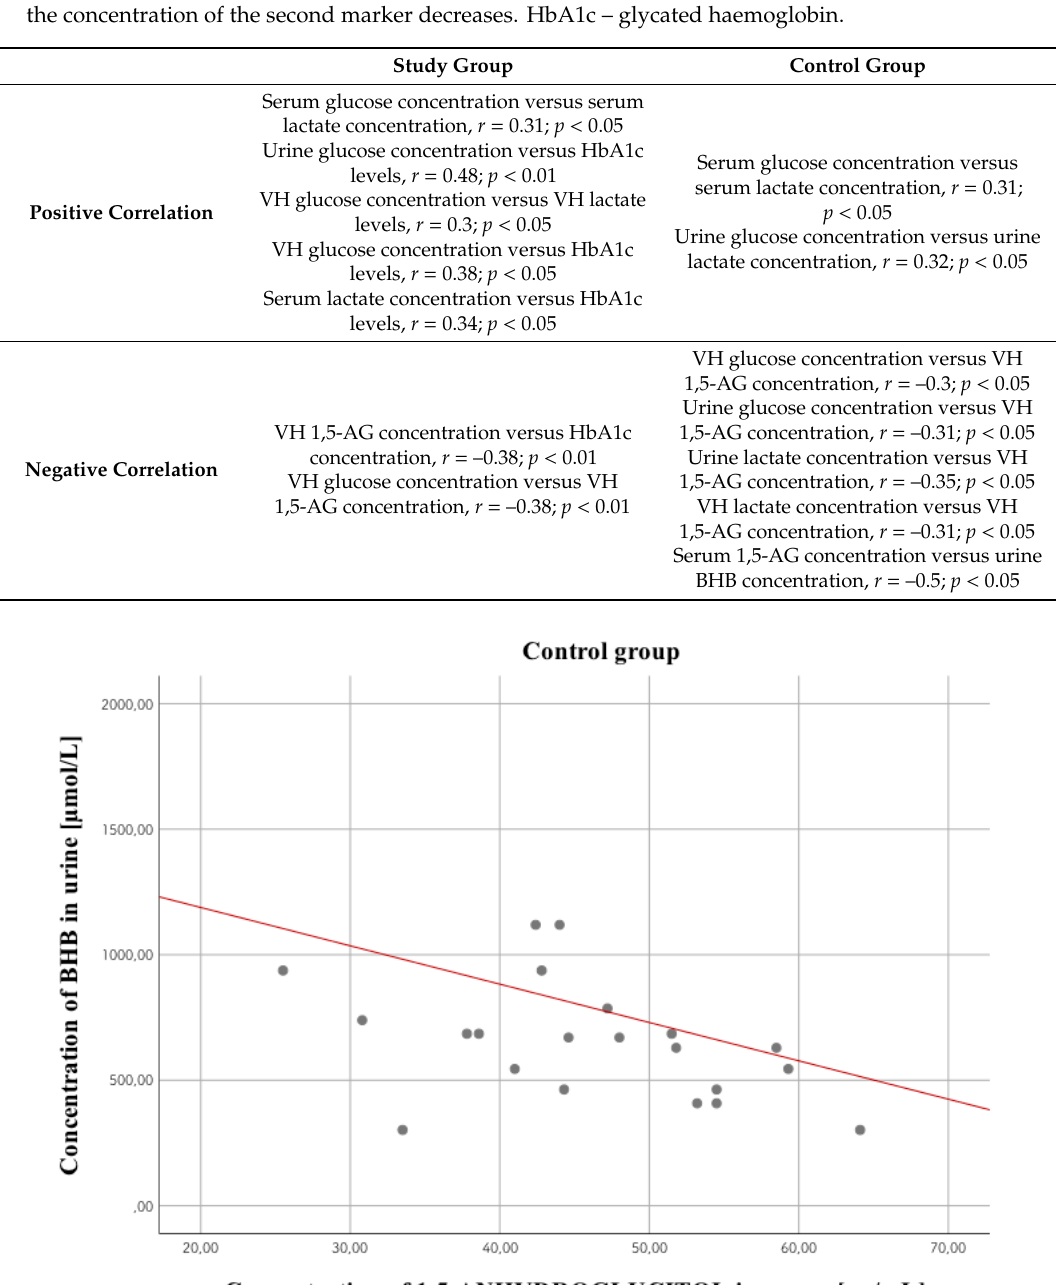
Figure 4. Correlation between serum 1,5-anhydroglucitol levels and urine BHB concentration in the control group. Dots correspond to the correlation between concentrations of both markers and the red line shows estimated correlation between markers.